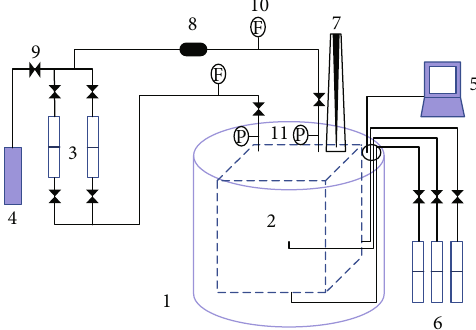
Figure 1: Diagram of the assembled true triaxial fracturing system. 1. Hardened steel cell. 2. Block sample. 3. Syringe pumps. 4. Pump liquid reservoir. 5. Acoustic emission receiver. 6. Hydraulic pump for stresses. 7. Drilling system. 8. Filter. 9. Isolated valves. 10. Flow transducer. 11. Pressure transducer.